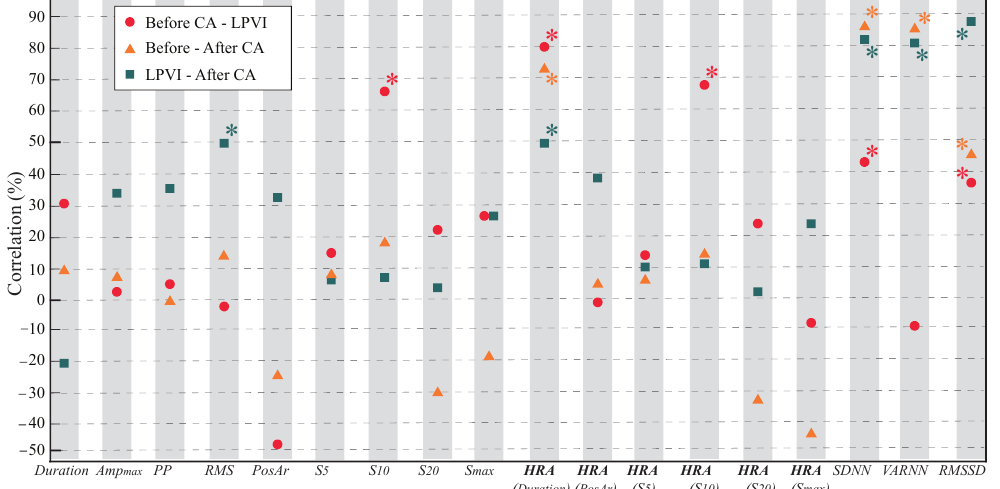
Figure 4. Pearson correlation between surface and invasive features for the variation measured between the recordings before CA and after LPVI (red), before the beginning and after the end of the CA procedure (orange), and after LPVI and after the end of the CA procedure (green). Statistically significant results are marked with asterisk ( ∗